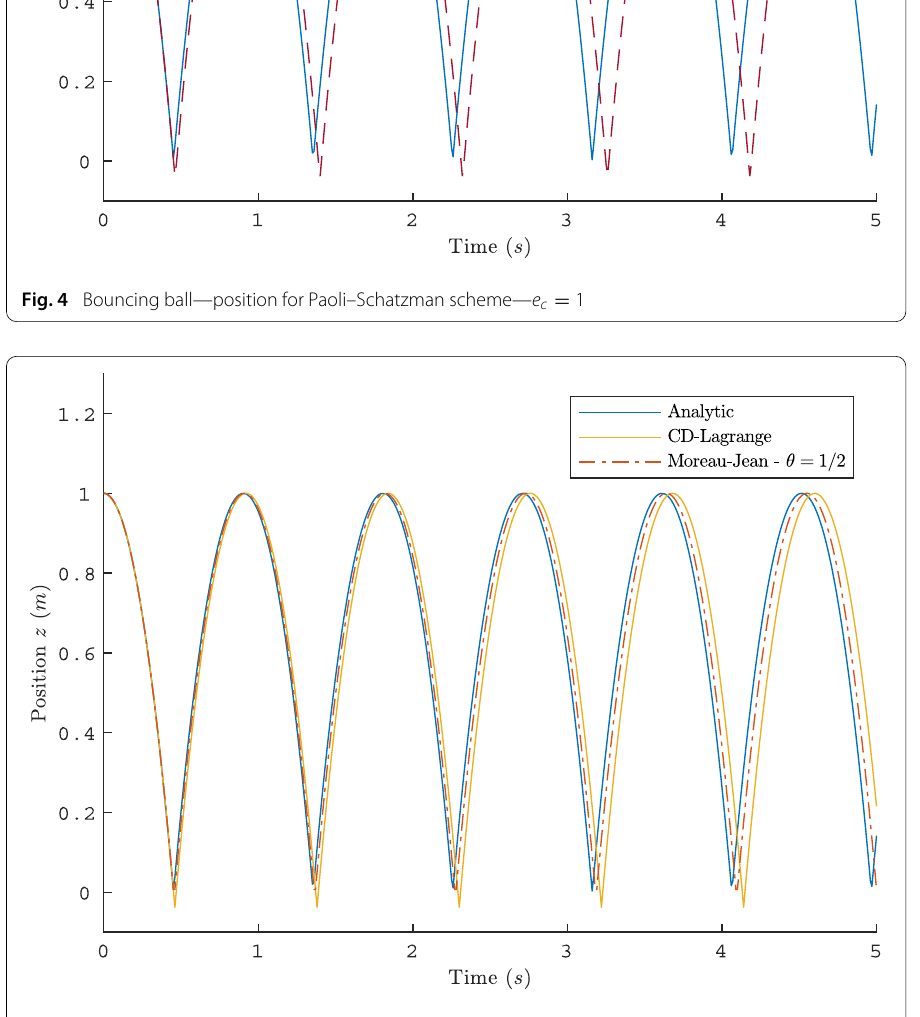
Fig. 5 Bouncing ball—position for Moreau–Jean and CD-Lagrange— e c = 1